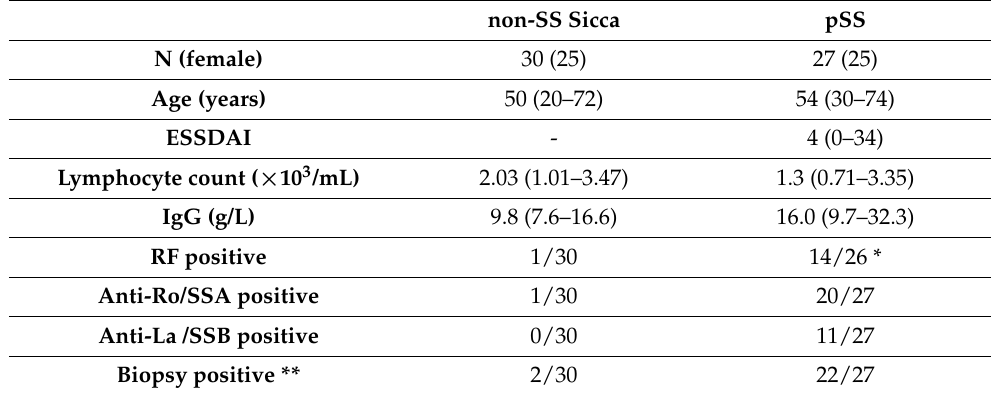
Table 1. Characteristics of patient group 1.